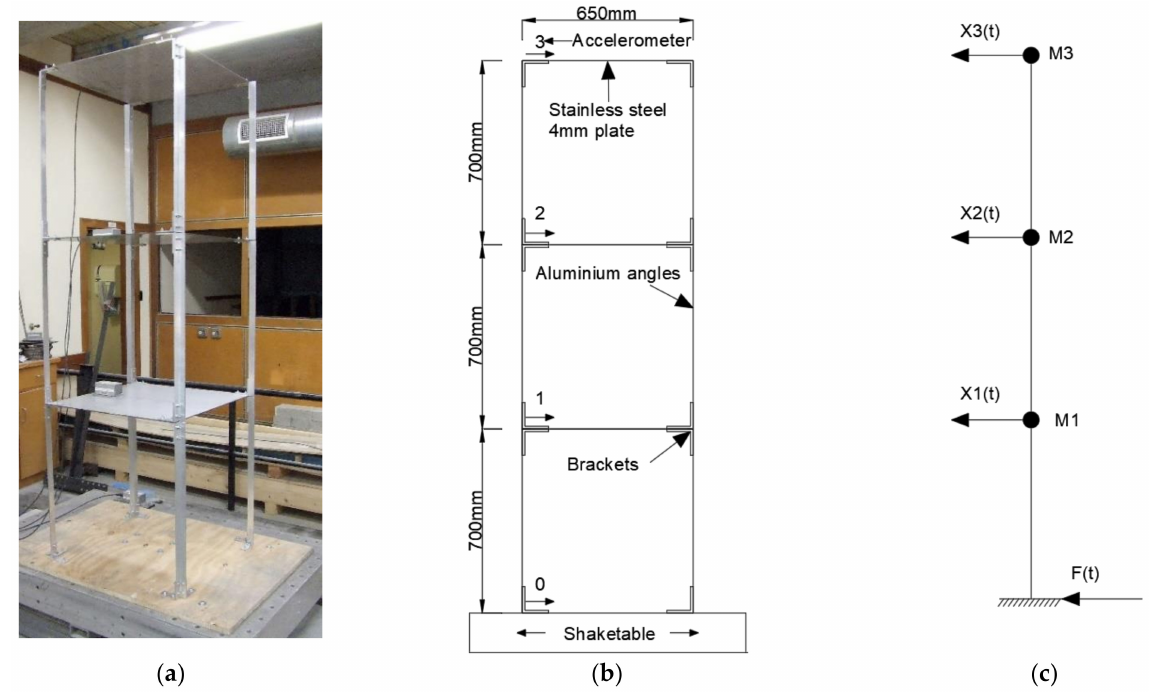
Figure 10. Three-storey frame [41]. ( a ) test model; ( b ) diagram of accelerometer locations and external dimensions; ( c ) its simplified three DOF system. Table 6. The structural states and labels.